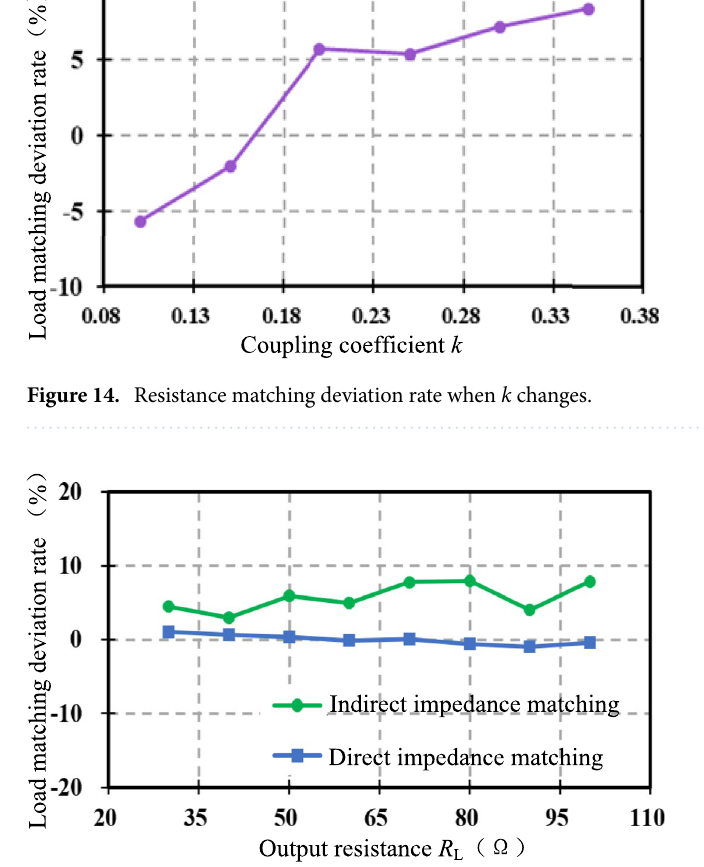
Figure 15. Comparison of load matching deviation rate.